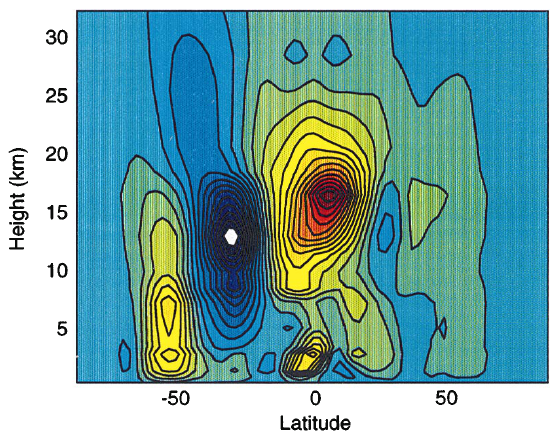
Fig. 4. Latitude–height distribution of contributions to the global AAM trend. The ordinate is height in kilometers (km). Positive contributions are colored from green to red , negative contributions from blue to